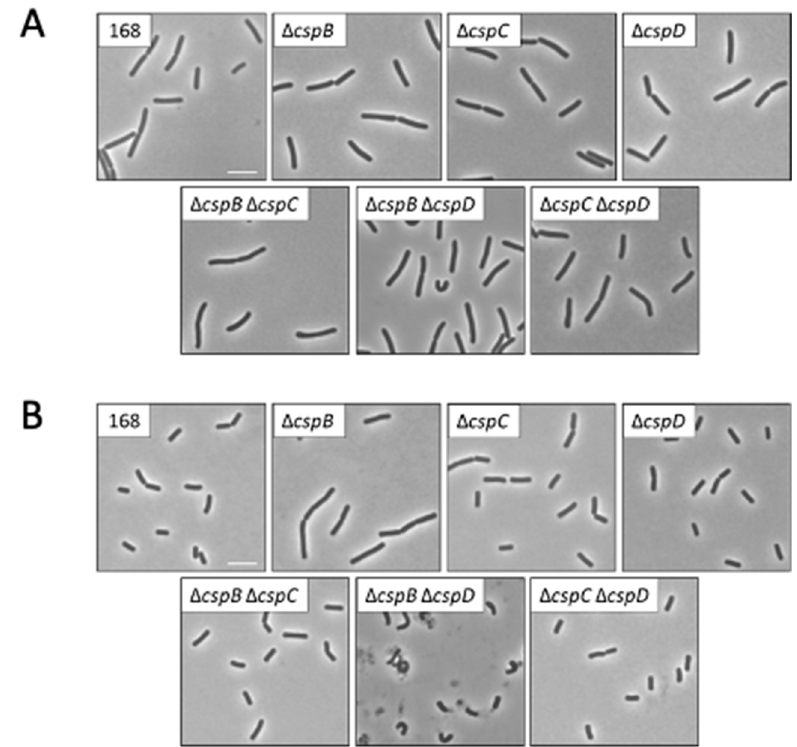
Figure 2. Phenotypic analysis of B. subtilis csp mutants. The wild-type strain B. subtilis 168 and the csp mutants GP1968 ( ∆ cspB ), GP1969 ( ∆ cspC ), GP2614 ( ∆ cspD ), GP1970 ( ∆ cspB ∆ cspC ), GP1971 ( ∆ cspB ∆ cspD ), and GP1972 ( ∆ cspC ∆ cspD ) were analyzed for morphology by phase-contrast microscopy. Scale bars, 5 µM. ( A ) Cells were cultivated in liquid LB medium at 37 °C to an OD 600 of 0.3–0.5. ( B ) Cells were cultivated in liquid LB medium at 37 °C overnight to the stationary growth phase.